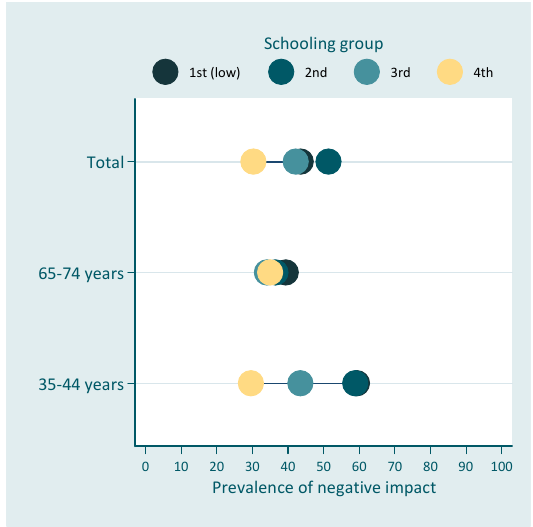
Figure 1. Prevalence of the negative impact of oral health on quality of life across education for the total population and among age-groups (equiplot). Schooling groups (in years of formal schooling): 1st = 0–3, 2nd = 4–7; 3rd = 8–11; 4th = 12+.